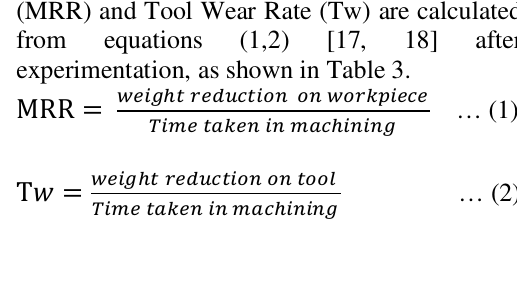
building a quadratic model of a response surface (CCD). Experiments are conducted with RSM and a Central Composite Design (CCD) matrix with Two-level factorial (full factorial) where it consists of 8 cube points, 6 center points, and 6 axial points with α =1.68179. Experimental design is an important stage in MINITAB software[15]. Material Removal Rate Experimental results of (MRR), (Tw)